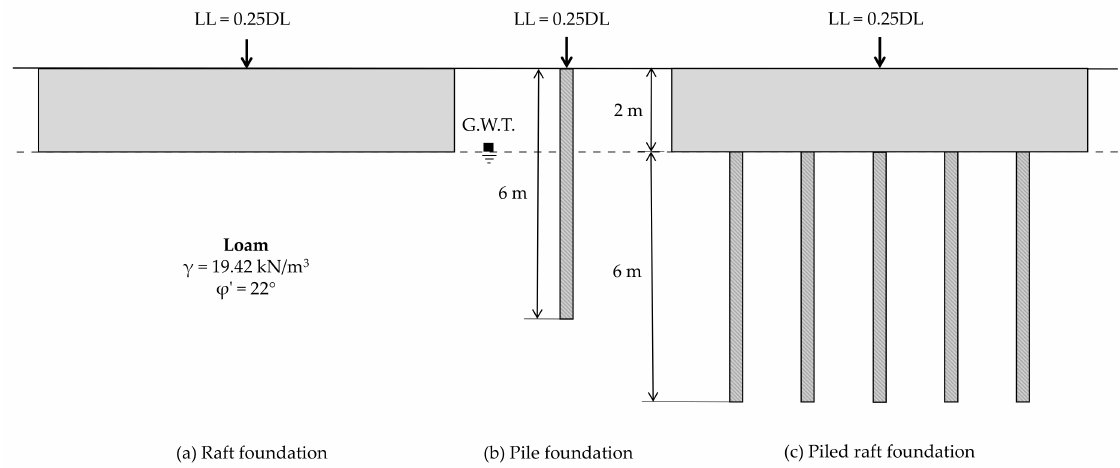
Figure 2. Idealized soil profile and designed